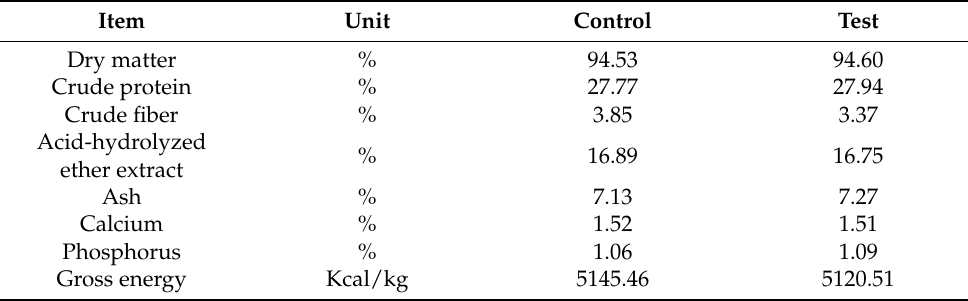
Table 1. Chemical composition of the experimental diets (dry matter